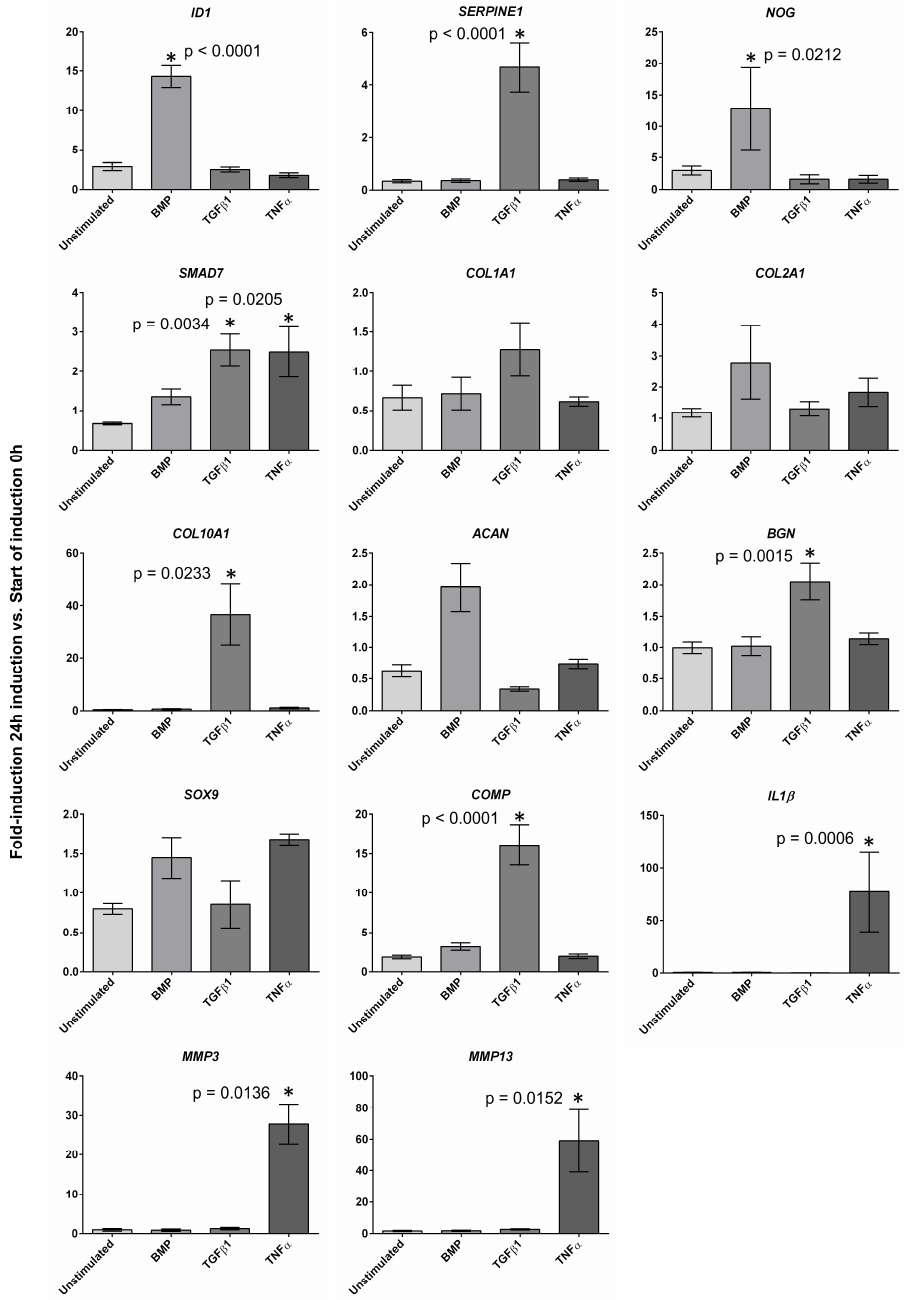
Figure 4. Gene expression of bone morphogenetic protein 2 (BMP2)-, transforming growth factor β 1 (TGF β 1)-, and tumor necrosis factor α (TNF α )-stimulated cells and unstimulated cells after 24 h given as fold induction of gene expression at the starting point of the stimulation 0 h (error bars SEM); significant increase after 24 h indicated for * p < 0.05 and exact values given in the figure.